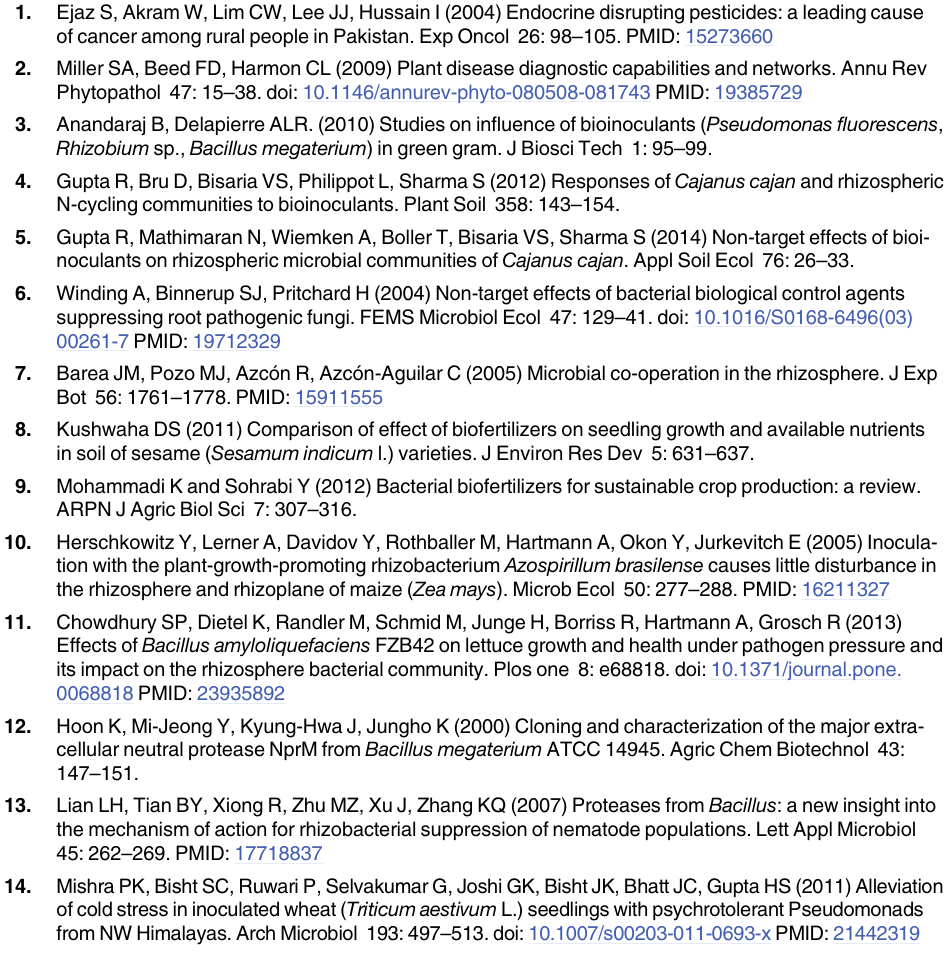
S5 Fig. Quantitative shifts in (Figure A) narG (Figure B) nir K (Figure C) nir S gene abun- dance and activity measured by q-PCR under different treatments by non-metric multidi- mensional scaling analysis. Hollow circles = nar G/ nir K/ nir S genes per g dry soil; solid circles = nar G/ nir K/ nir S transcripts per g dry